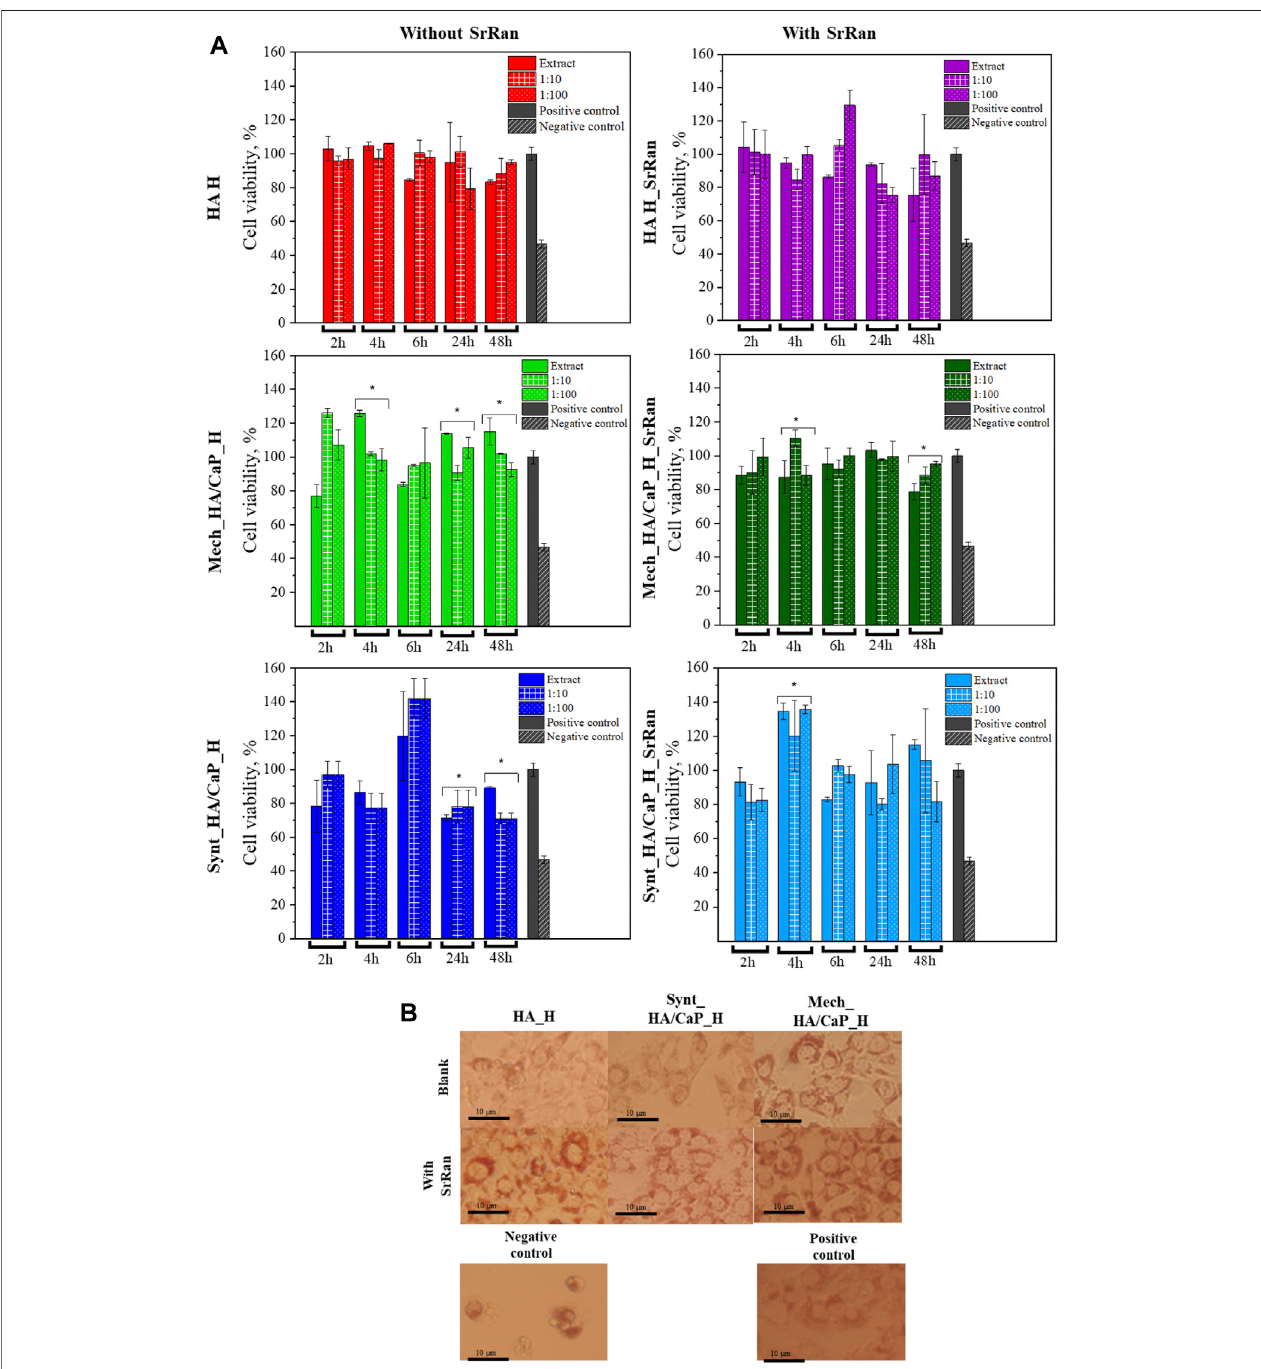
FIGURE 9 | In vitro evaluation of lyophilized hydrogels. (A) Cytotoxicity of obtained hydrogels after neutralization (*annotate the statistical difference at a p < 0.05); (B) morphology of 3T3 cells treated with hydrogel extracts after 24-h incubation.